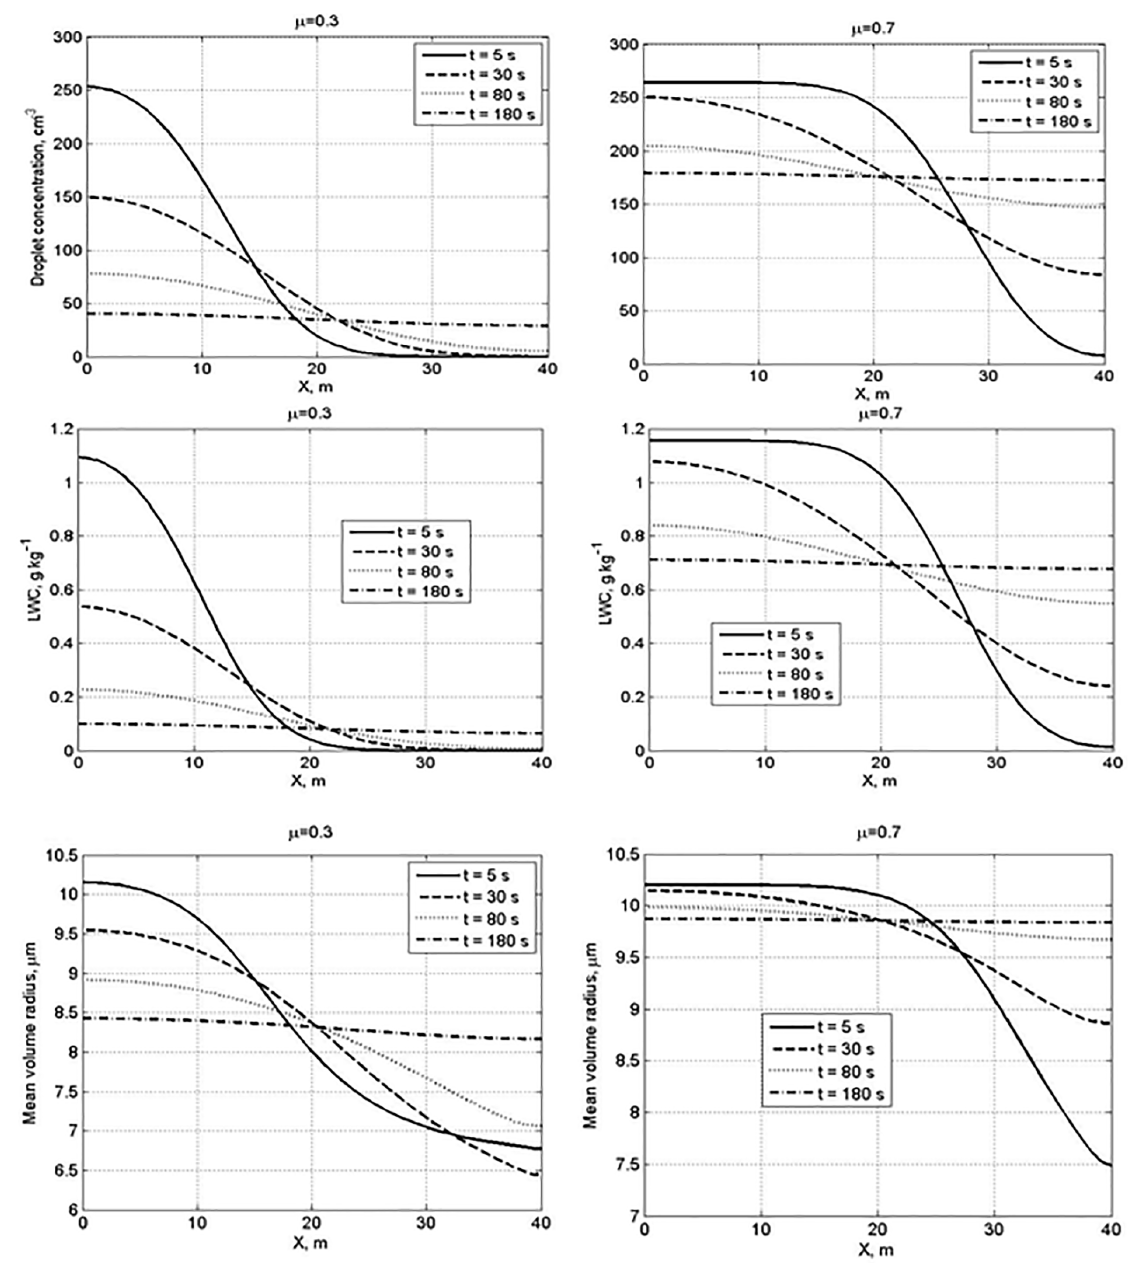
Figure 5. Spatial dependences of droplet concentration, LWC and the mean volume radius within the mixing volume at different time instances at a narrow initial DSD. The initial mixing parameters are RH 2 = 80%, T = 10 ◦ C, p = 828.8mb and L = 40m.